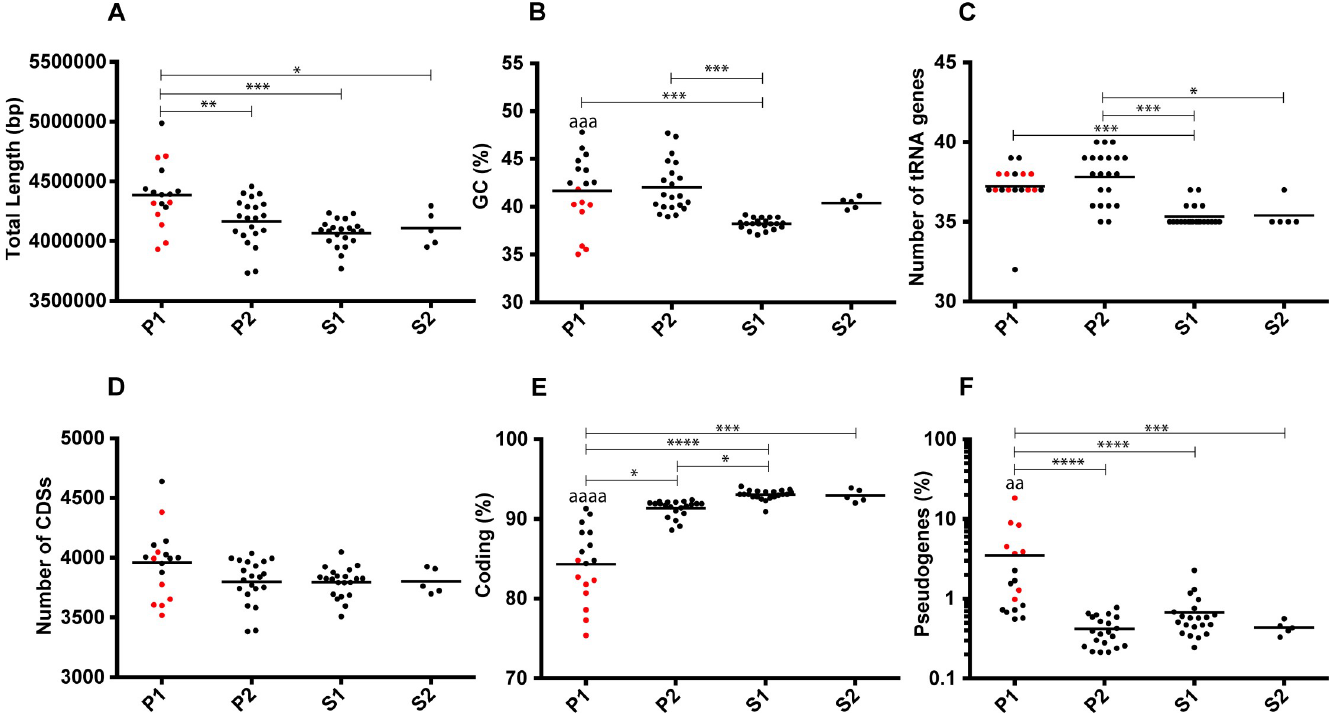
Fig 4. Distribution of (A) total length, (B) GC %, (C) number of tRNA genes, (D) number of CDSs, (E) coding % and (F) pseudogenes % (values in log) in the four major subclades. The points representing the genome-specific values of the species that diverged after node 1 in Fig 1 ( L . interrogans , L . kirschneri , L . noguchii , L . santarosai , L . mayottensis , L . borgpetersenii , L . alexanderi and L . weilii ) are in red. The " � " represent the level of significance between the different groups: � P � 0.05, �� P � 0.01, ��� P � 0.001, and ���� P � 0.0001. The level of significance between the two P1 groups separated by node 1 is represented by the same code, but for the sake of clarity the symbol is